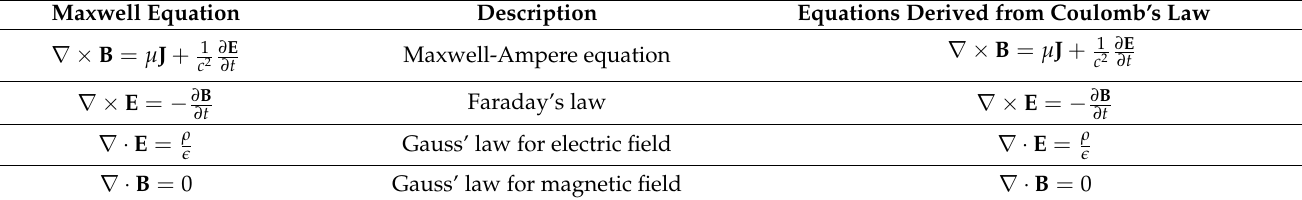
Table 2. Maxwell equations for electromagnetic fields E and B compared to differential equations governing the vector fields B and E derived from Coulomb’s